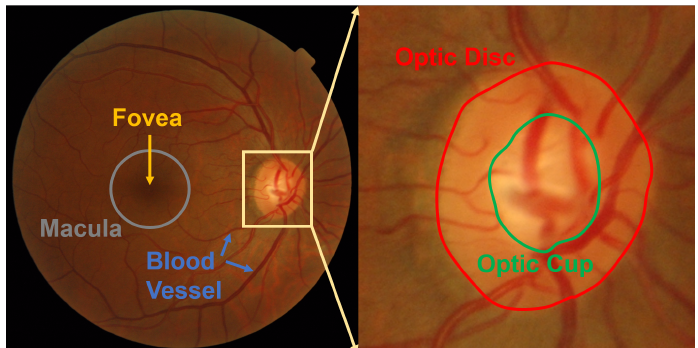
Figure 1. Example of posterior fundus image.